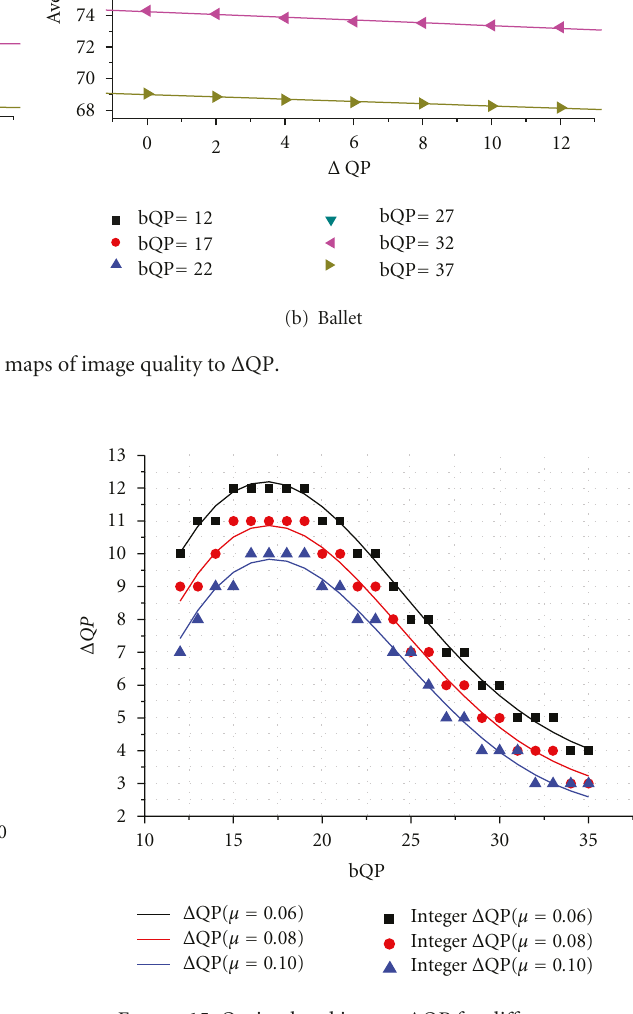
Figure 15: Optimal and integer Δ QP for di ff erent μ